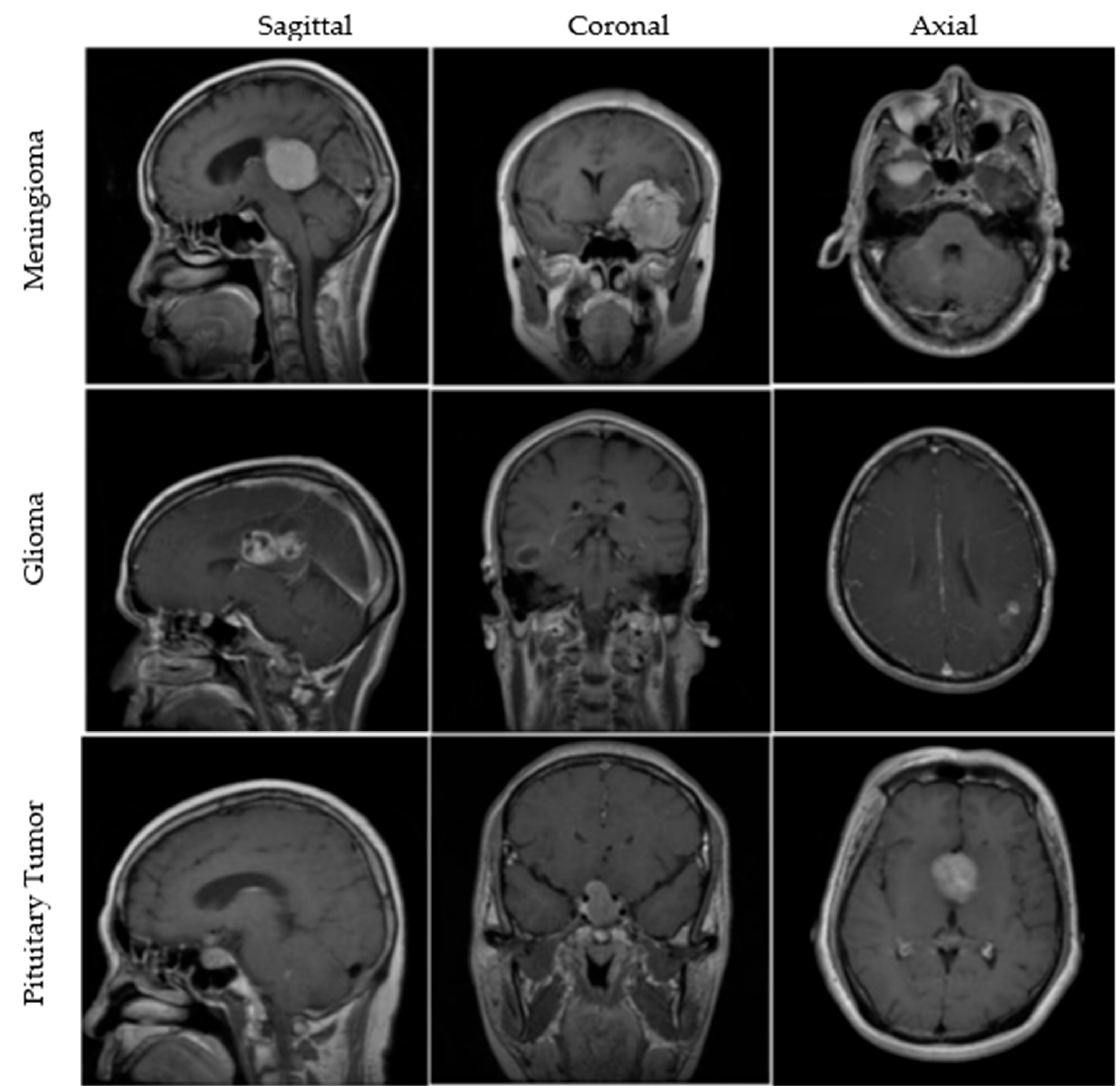
Figure 1. MRI images from the figshare dataset are shown in sagittal, coronal, and axial cut planes for meningiomas, gliomas, and pituitary tumors.